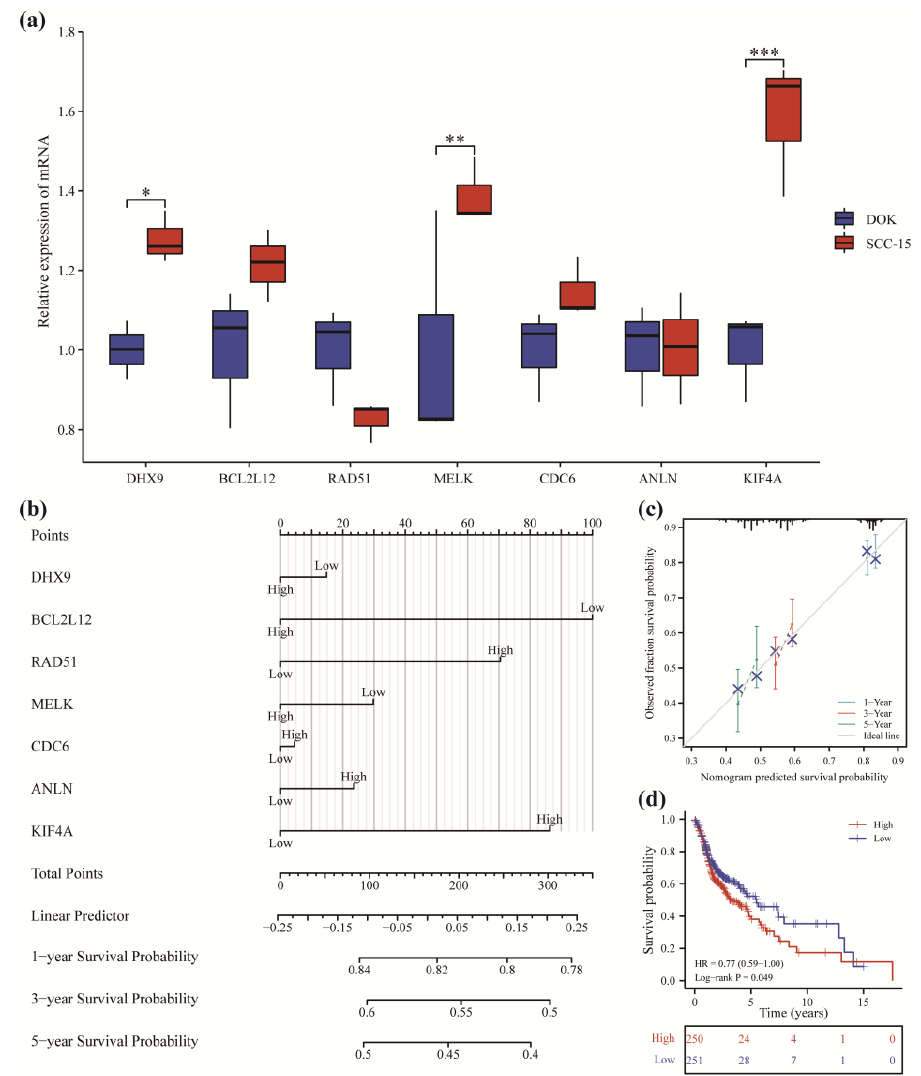
Figure 7. Prognostic analysis of the model genes. ( a ) Relative mRNA expression differences in DOK cells and SCC-15 cells. The experiments were repeated in three independent experiments (* p < 0.05; ** p < 0.01; *** p < 0.001). ( b ) Nomogram of prognostic correlation of model genes. ( c ) Calibration diagram of 1, 3, and 5 years. ( d ) Kaplan – Meier survival curve was plotted based on the risk score to analyze the overall survival.